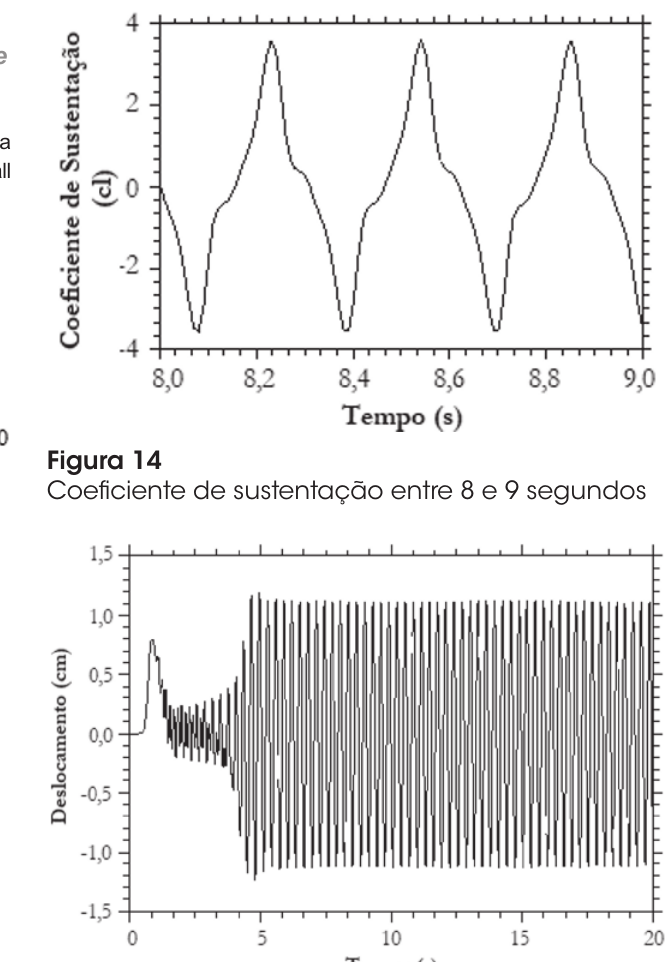
Figura 12 Deslocamento vertical do vértice e do centro da estrutura. Resultados obtidos por Wall e Ramm [12]